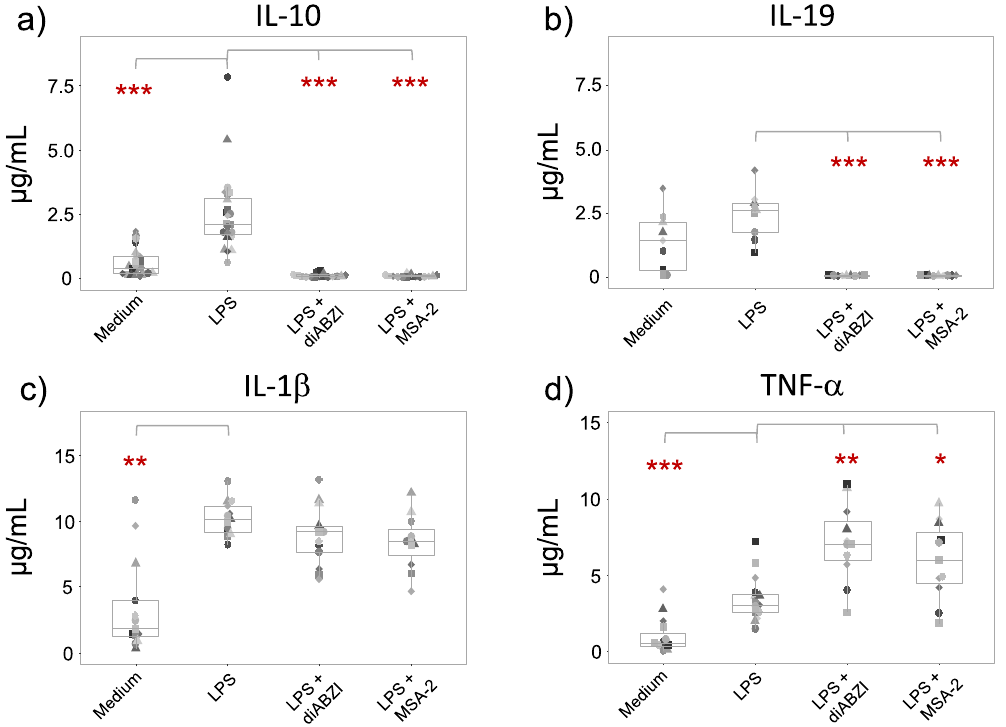
Figure 2. STING ligands suppress LPS-induced secretion of anti-inflammatory but not pro-inflammatory cytokines. Purified monocytes were cultured in medium only or were stimulated with 100 ng/mL LPS in the absence or presence of 100 nM diABZI or 25 µM MSA-2 as indicated. Supernatants were collected after 24 h, and cytokines were quantified by ELISA. ( a ) IL-10 (n = 15–23). ( b ) IL-19 (n = 9). ( c ) IL-1β (n = 11–13). ( d ) TNF-α (n = 11–15). Statistical significance was calculated between medium and LPS and for LPS + diABZI and LPS + MSA-2 groups in comparison to LPS only as indicated by the horizontal bars. Wilcoxon signed rank test. was used. *p < 0.05, **p < 0.01, ***p <